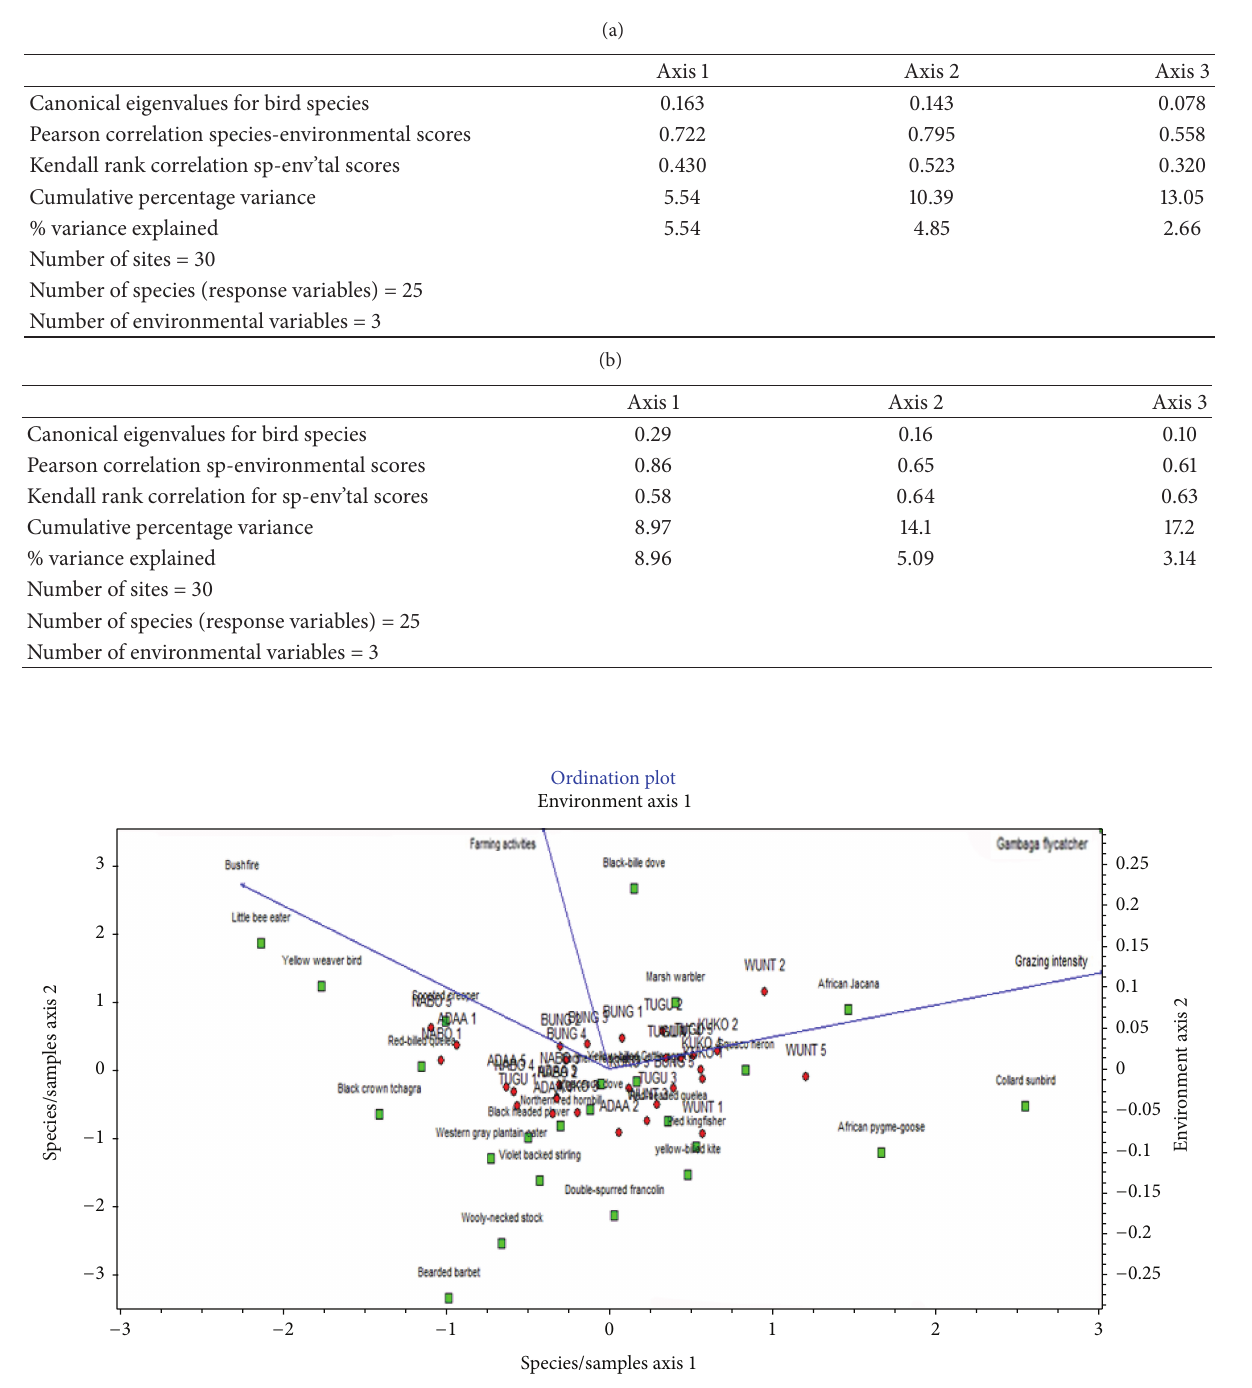
Figure 6: Canonical correspondence analysis (CCA) ordination diagram, showing the relationship between environmental variables and bird species across the six wetlands, in the wet season. The red circles represent sample plots, the green squares represent bird species, and the arrows represent each of the environmental variables plotted pointing in the direction of maximum change of explanatory variables across the six